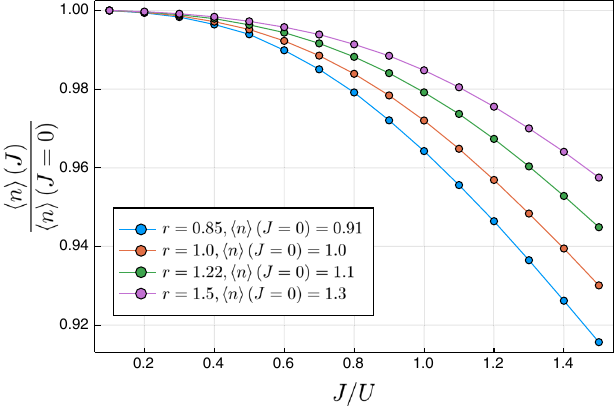
FIG. 8. Local density of particles as a function of the hopping- to-interaction ratio J=U , within DMFT NCA, for different values of the pump-to-loss ratio r , normalized to the values of the single- site problem. We see that the density decreases with J=U , a specific feature of driven-dissipative lattices with two-body losses (see the main text), which is captured by DMFT. Parameters: 10 . The drive values used are marked on the z ¼ 50 and dim H ¼ y axis in Fig.